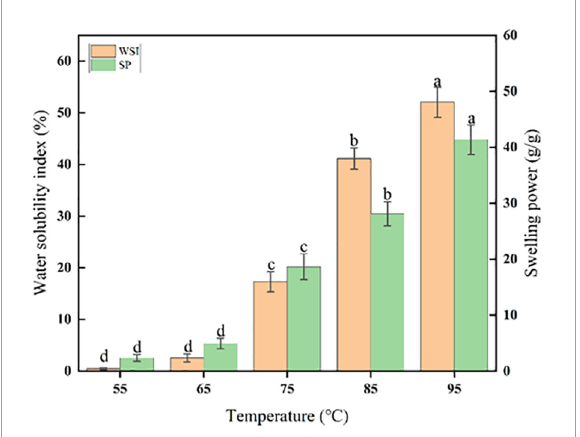
FIGURE2 Average WSI and SP of sorghum starch. (a–d) Different letters indicate significant differences ( p <